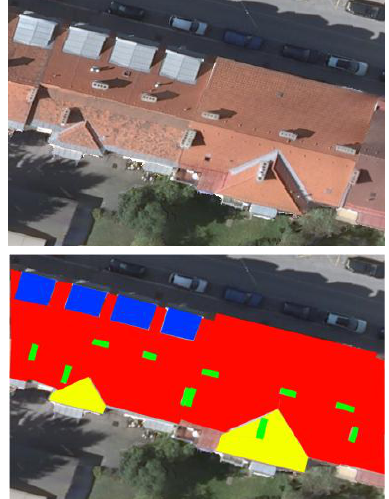
Figure 10: Extract of an orthophoto of our test data set and overlaid Segmentation of roofscape into different roof categories (red: major planes; yellow: minor planes; green: chimneys; blue: dormer windows). [Source: Detail of the Graz test